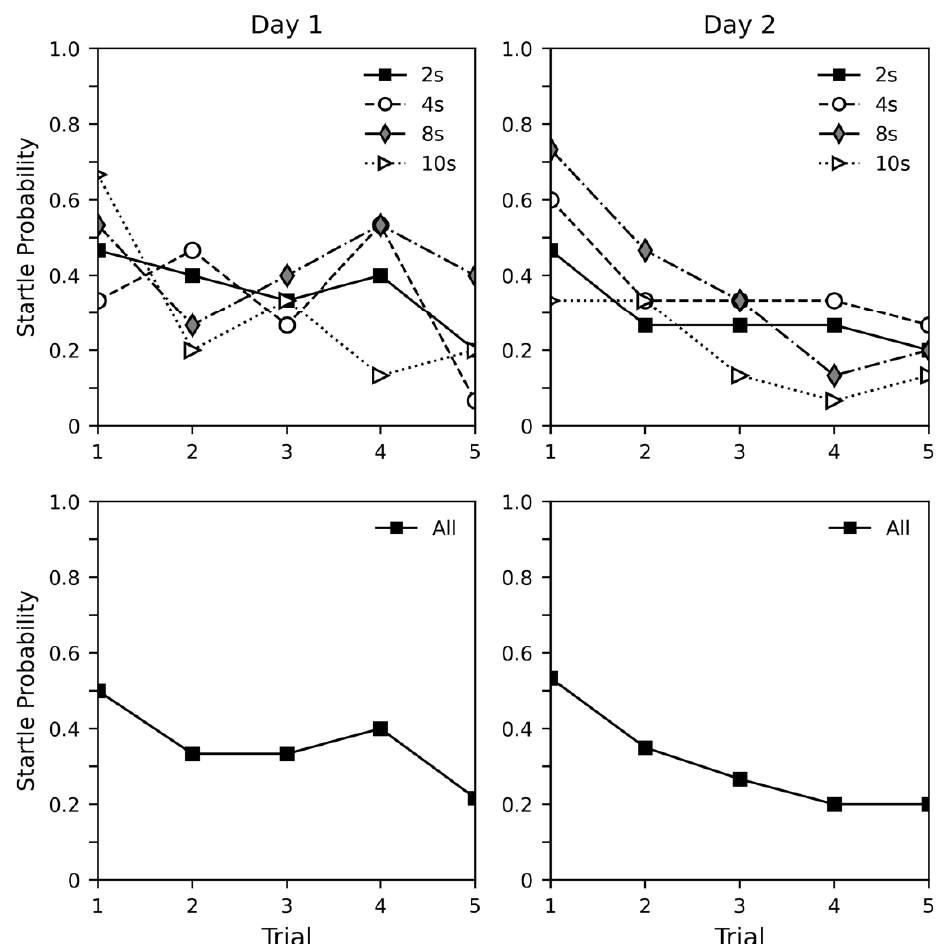
Figure 2. Probability of startle in response to light change in experiment 2. All subjects showed a startle response when recollected after the final trial. The top row shows the data split by stimulus duration. The bottom row shows all data pooled together. Table 2. Experiment 2 Startle Probability Regression Analysis.